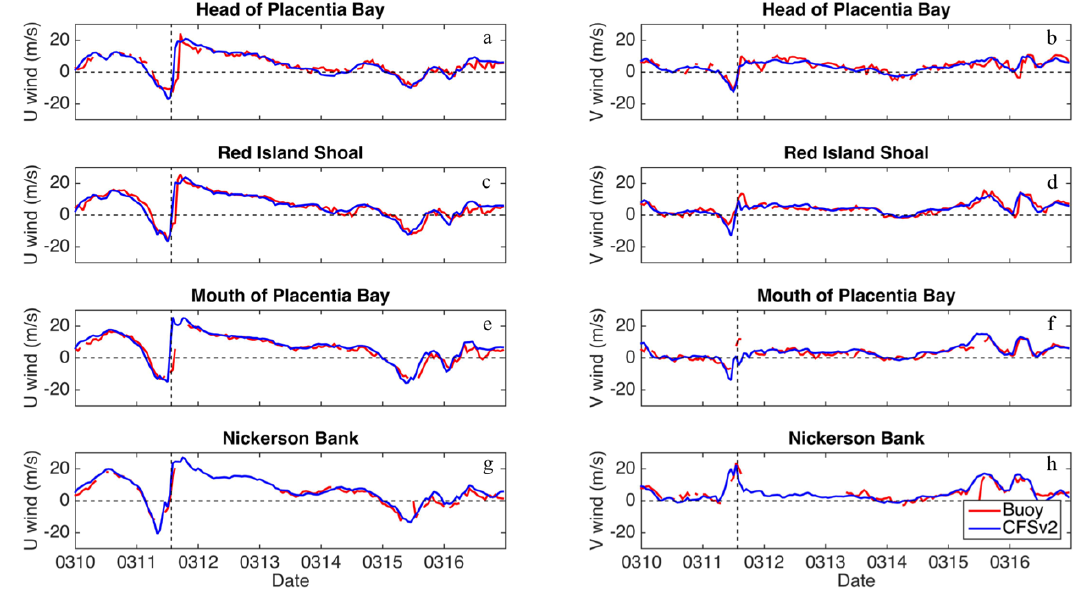
Figure 5. Comparison between buoy (red) and CFSv2 (blue) zonal winds ( left panels ) and meridional winds ( right panels ) (m s −1 ) at HP, RI, MP, and NB. The horizontal black dashed lines denote U = 0 m s −1 and V = 0 m s −1 . The vertical black dashed lines denote the time of landfall.